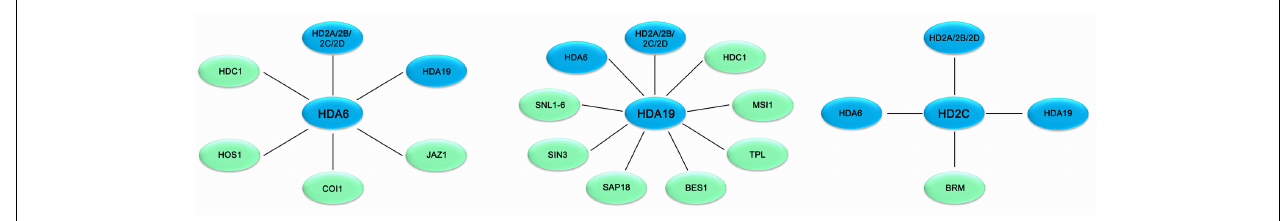
FIGURE 1 | Association networks of HDACs and interacting proteins in plant stress response in Arabidopsis . HDACs are associated with various protein involved in stress response in Arabidopsis . Solid bars indicate physical interaction between HDACs (blue) and other protein